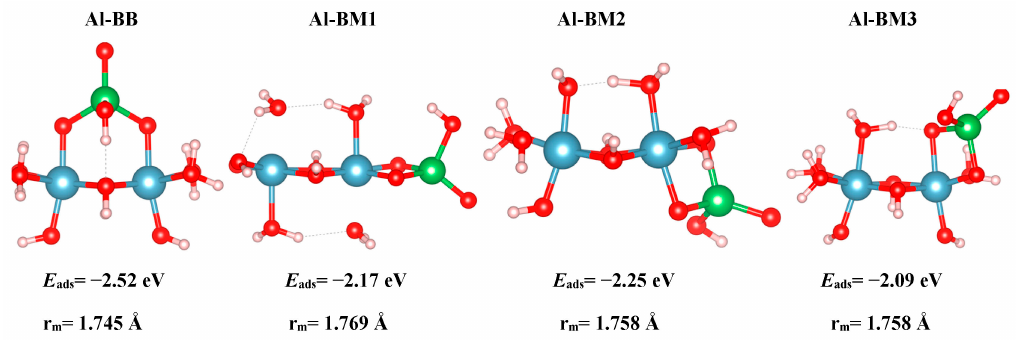
Figure 6. Optimized cluster structures. From left to right: Al-BB, Al-BM1, Al-BM2, and Al-BM3. Aluminum, oxygen, hydrogen, and arsenic are represented by the colors blue, red, white, and green respectively. r m is the As-O cluster averaged distance for the As-cluster model.